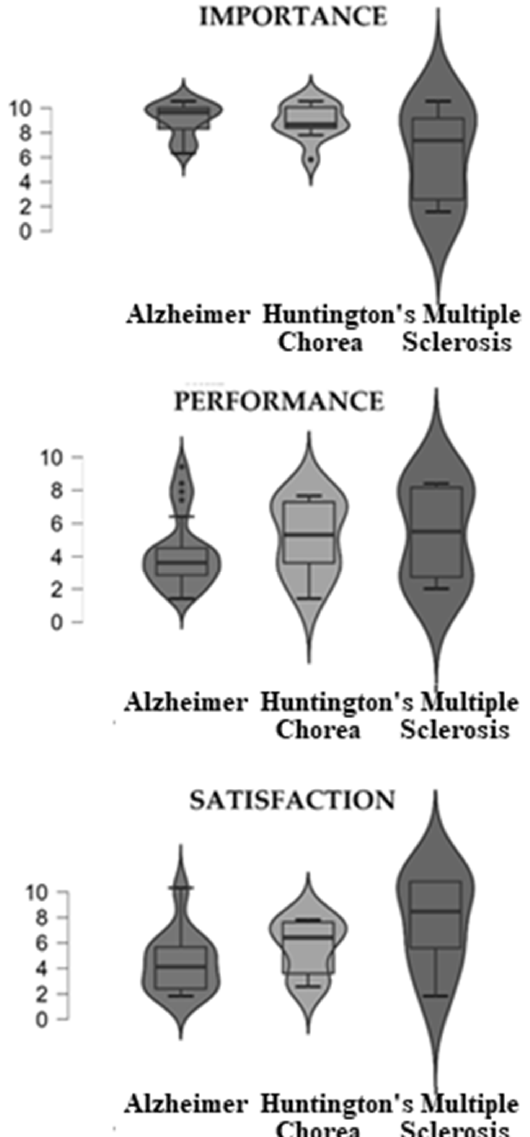
Figure 1. Box plots on COPM variables across pathologies.